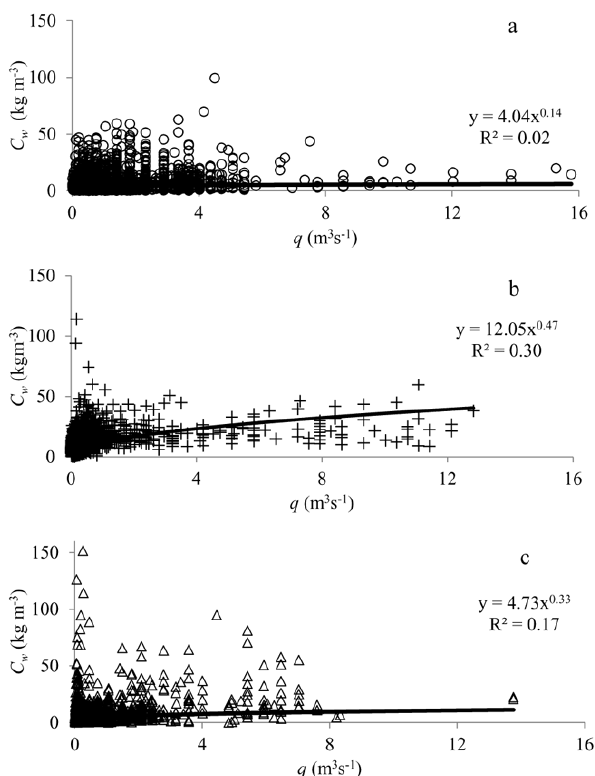
Fig. 3. Sub-hourly instantaneous suspended sediment concentration ( C w in kgm − 3 ; y-axis) versus discharge flow rate ( q in m 3 s − 1 ; x-axis) for (a) Andit Tid, (b) Anjeni, and (c) Maybar.